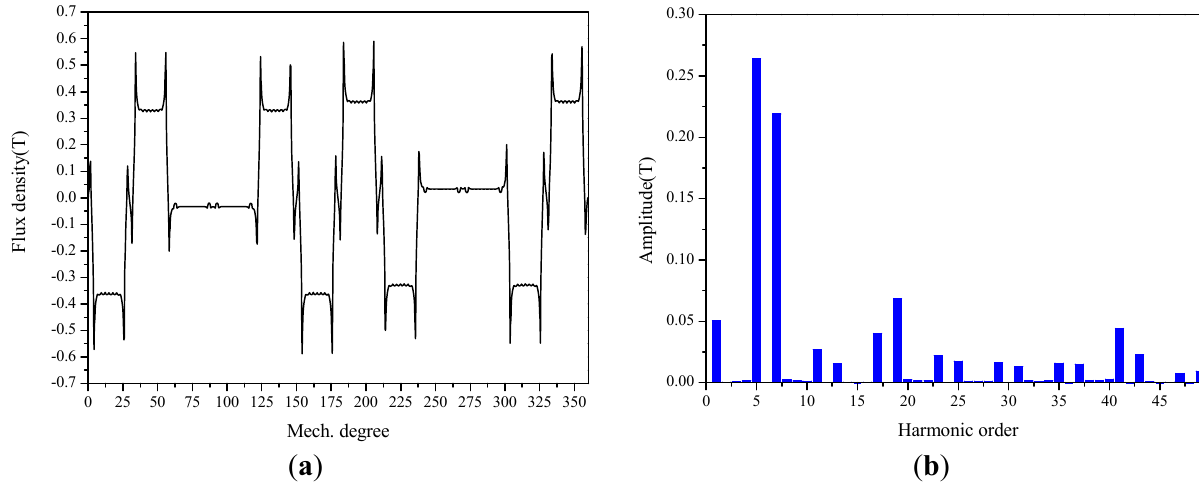
Figure 6. MMF harmonic analysis of the 24-slot symmetric six-phase PMSMs having two adjacent coils per phase and unequal teeth widths: ( a ) winding-produced air-gap flux density; and ( b )